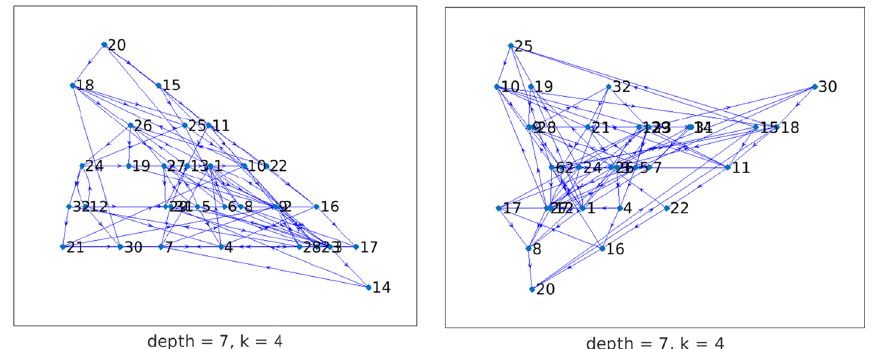
Fig. 9 Network ibm32: Both the sets C ( T 20 out ) (left) and C ( T 20 in ) (right) has { ℓ , k } -chained structure with k =